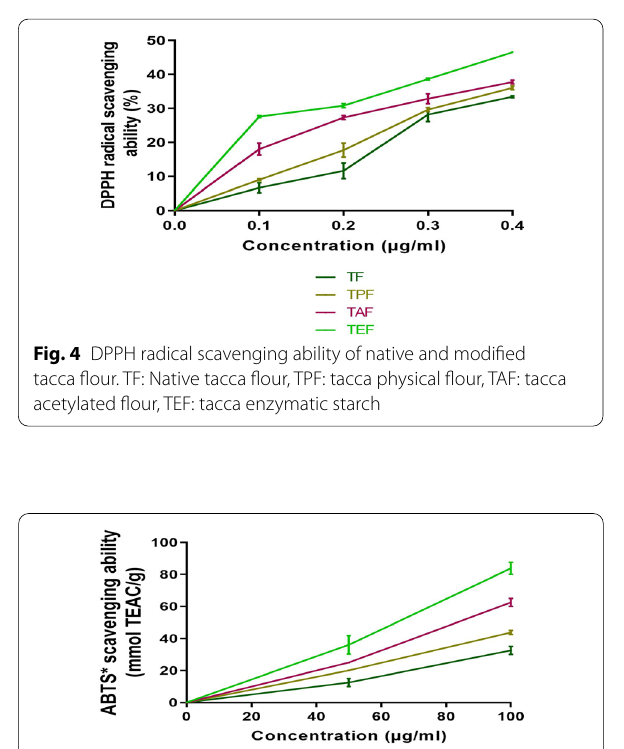
Table 2 Haematological parameter of rats fed with tacca enzymatic biscuit